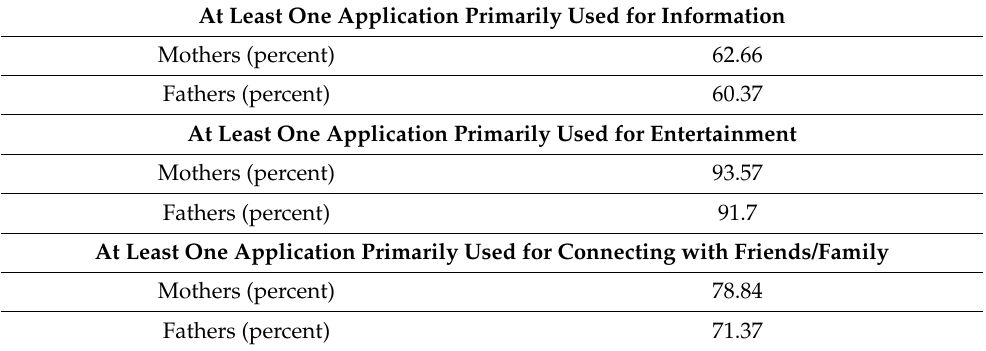
Table 3. Percentage of parents using social media, by